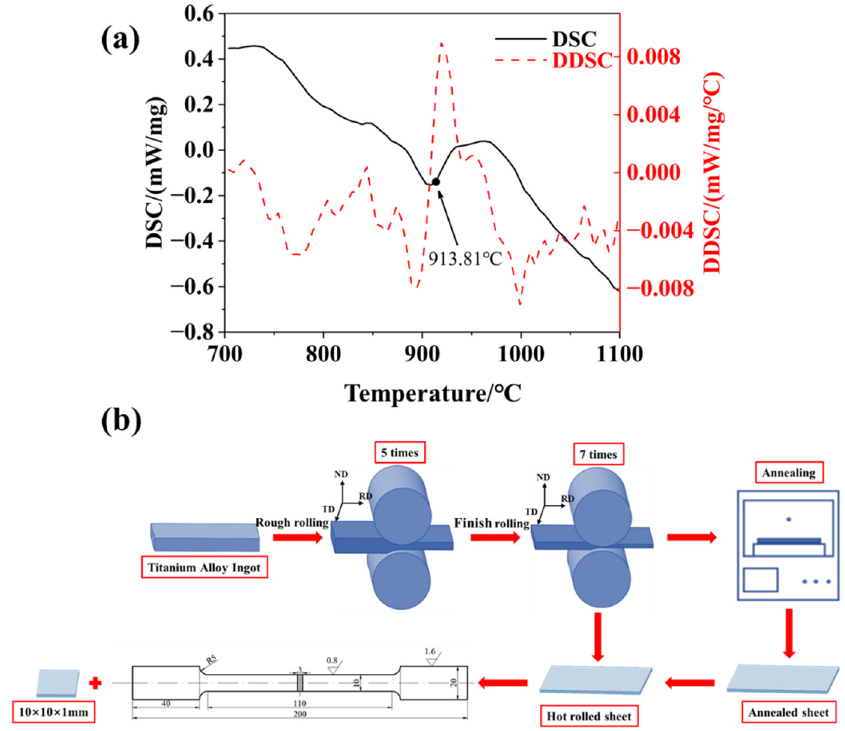
Figure 1. ( a ) DSC and DDSC curve of TA10 alloy; ( b ) experimental process. TA10 alloy sheets were cut into 10 × 10 × 3 mm 3 (Error range: ±0.3) metallographic